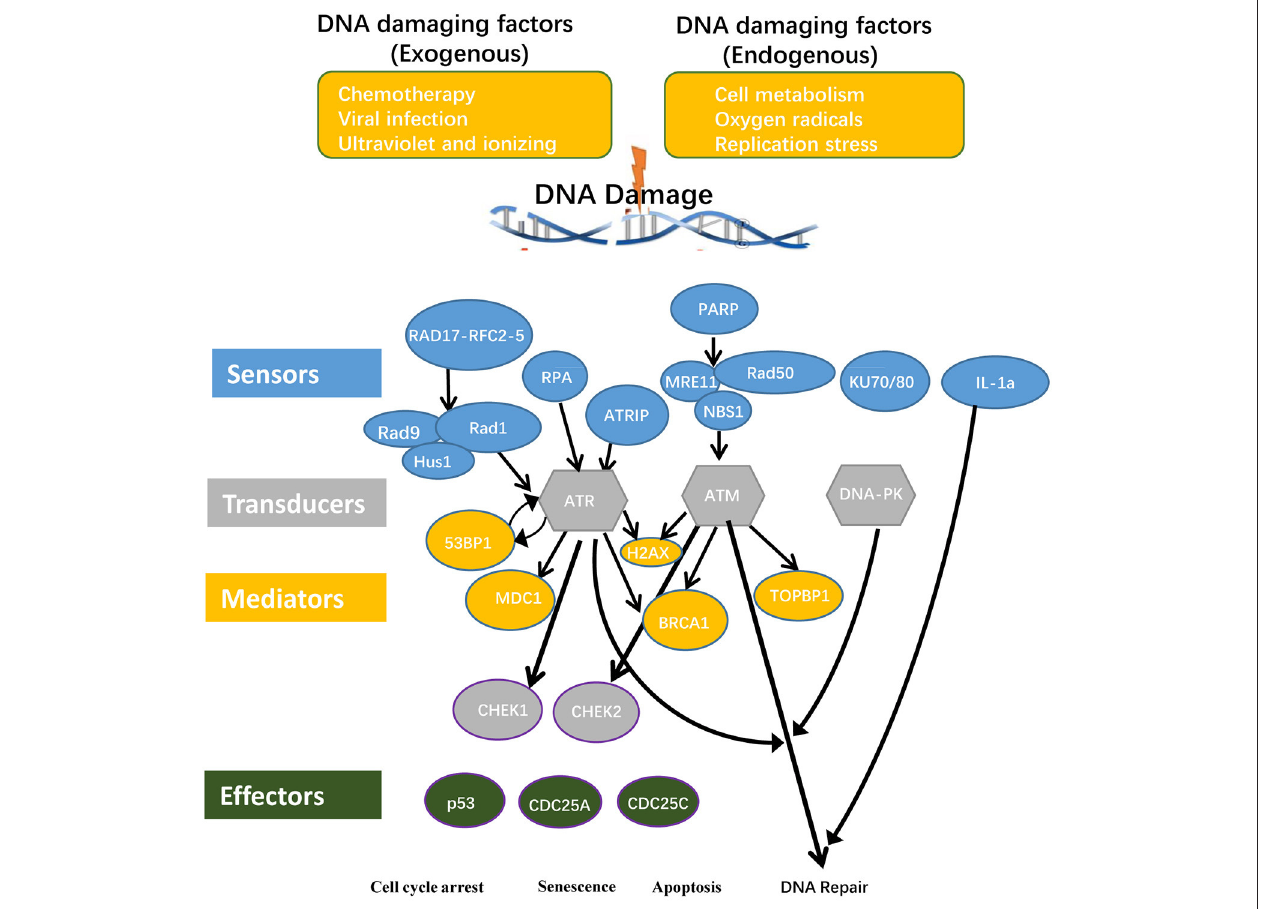
FIGURE 2 | DNA damage checkpoints and the components involved in their signal transduction pathways are classified in to conceptual categories named sensors, mediators, transducers, and effectors. Consequently, DNA damage may lead to cell cycle arrest, senescence, and apoptosis. RAD17, RAD17 checkpoint clamp loader component; RFC, Replication factor C; RAD9, chromatin-binding protein; RAD1, RAD1 checkpoint DNA exonuclease; HUS1, Hus1 checkpoint homolog; RPA, replication protein A; ATRIP, ATR interacting protein; PARP1, Poly(rC)-binding protein 1; PARP2, Poly(rC)-binding protein 2; MRE11, meiotic recombination 11 homolog A; RAD50, RAD50 homolog; NBS1, Nibrin; Ku70, X-ray repair cross complementing 6 (XRCC6); Ku80, X-ray repair cross complementing 5 (XRCC5); 53BP, P53 binding protein 1; MDC1, mediator of DNA damage checkpoint protein 1; H2AX, H2A histone family, member X; BRCA1, Breast cancer 1; TopBP1, topoisomerase II binding protein 1; ATM, Ataxia telangiectasia mutated; ATR, Ataxia telangiectasia and Rad3 related; DNA-PK, DNA-activated, catalytic polypeptide; CHEK1, checkpoint kinase 1; CHEK2, checkpoint kinase 2; CDC25A, cell division cycle 25A; CDC25C, cell division cycle